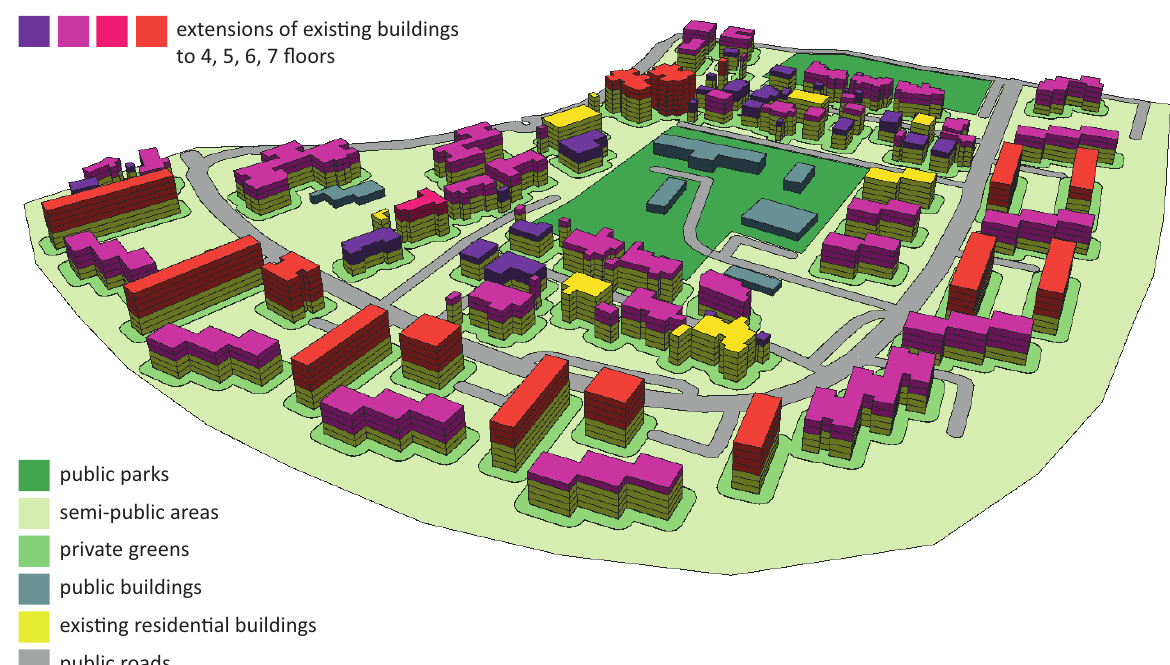
Figure 5. Alternative 3: “Business as usual” (preservation of previous design with additional